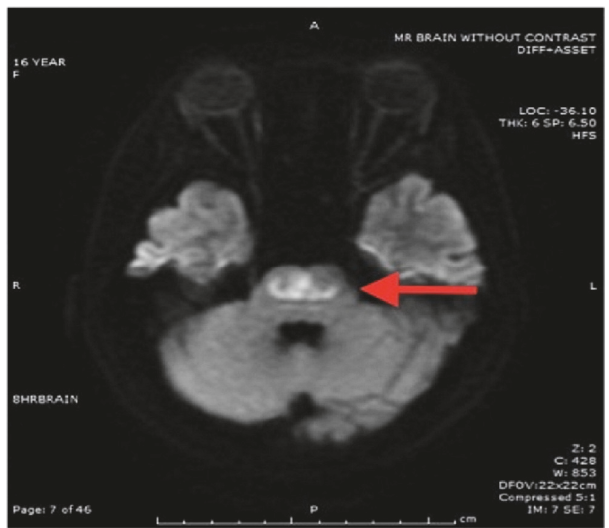
Figure 3: Restricted diffusion in pons with relative sparing of corticospinal tract.